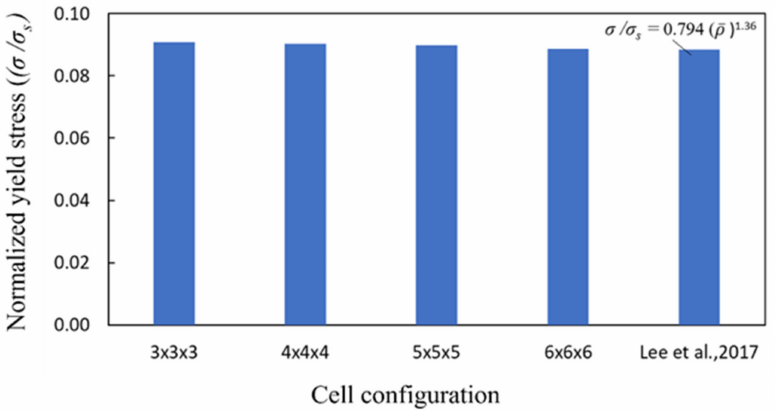
Figure 4. Convergence study of normalized yield strength values for different cell configurations of P-S ( ρ = 20% ) compared with calculated value from Lee et al.